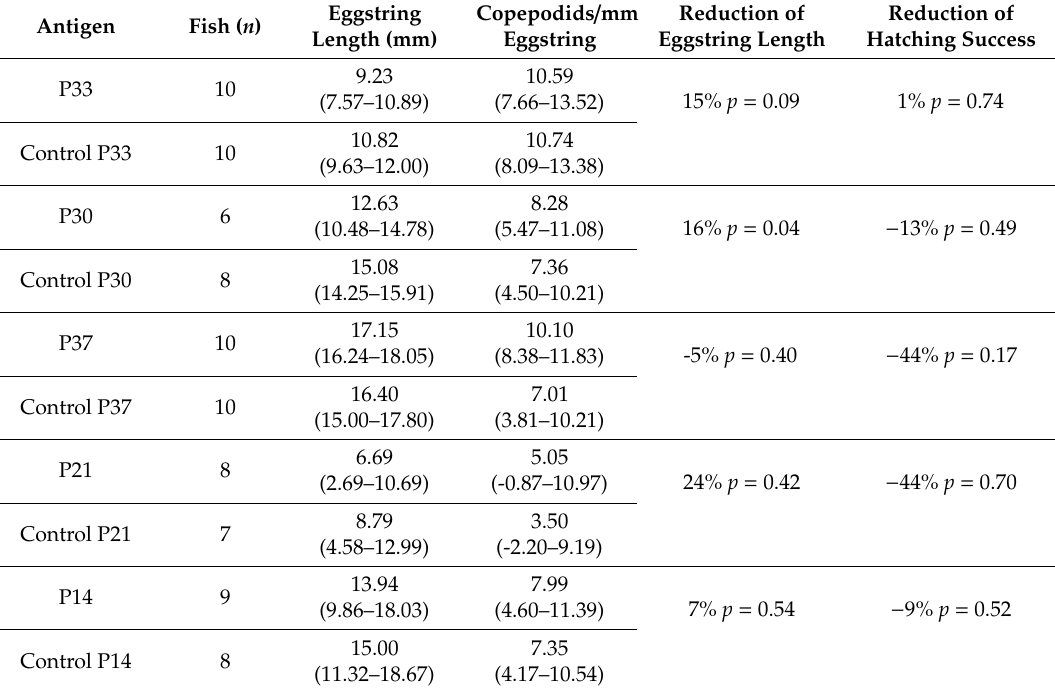
Table 3. E ff ect of vaccination on sea lice eggstring length and hatching in the single tank model.